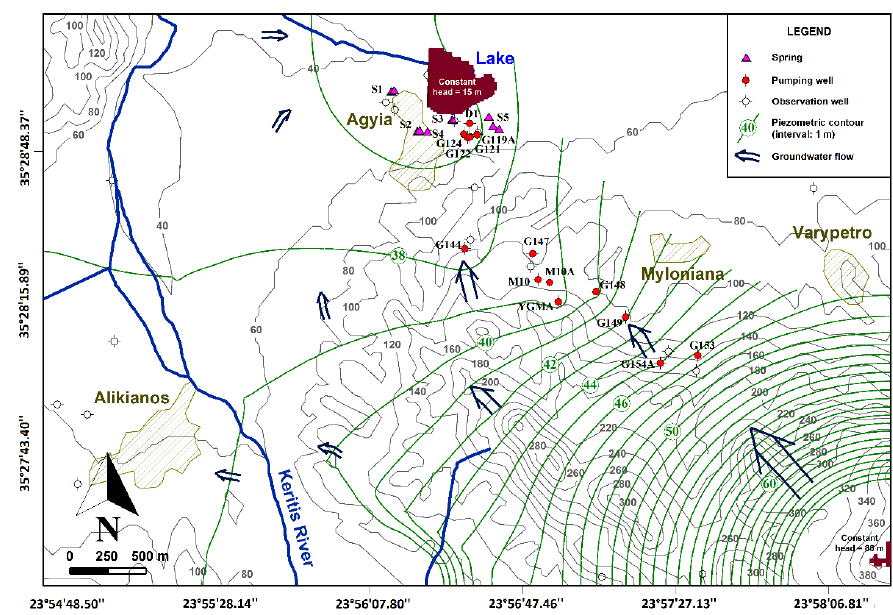
Figure 10. Piezometric map in the modeling area. Additional data from [21] contributed to this design.